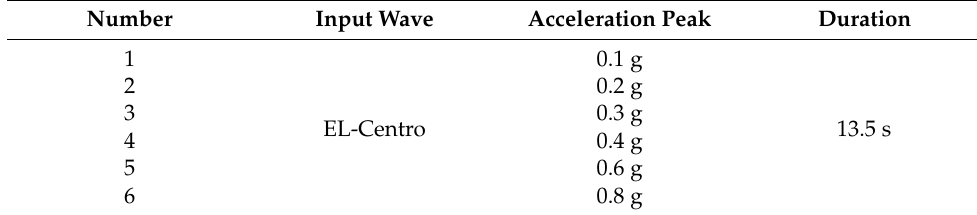
Figure 6. Schematic view of loading ( a ) static loading; ( b ) shaking table loading. Table 3. The test loading sequence.